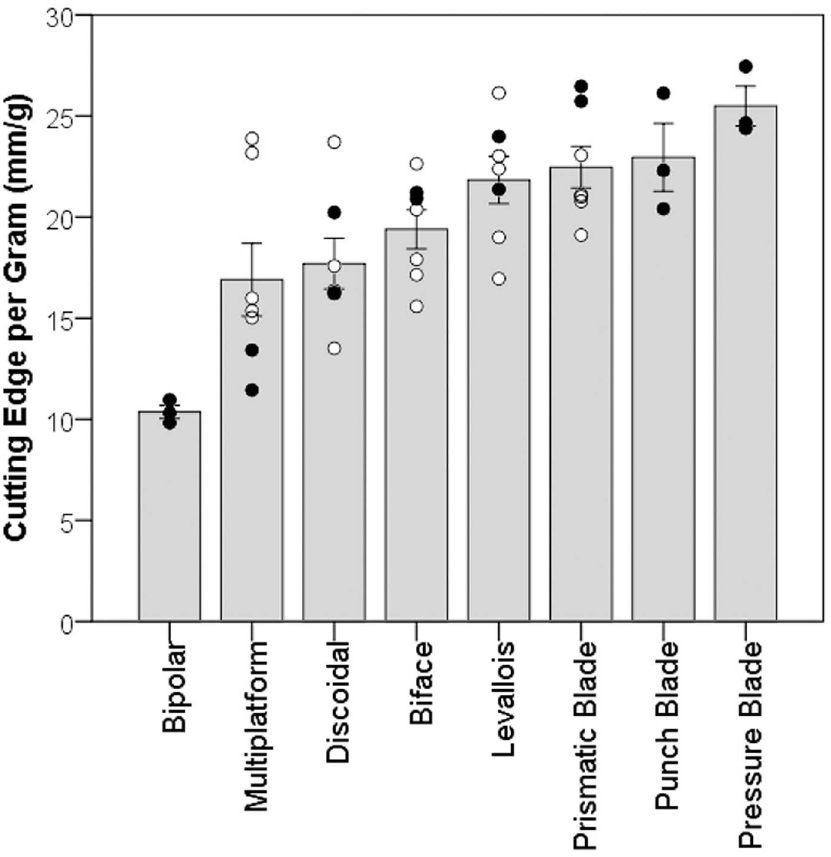
Fig 2. Bar chart, with one standard error bars and each data point superimposed, showing the cutting edge per gram values for each repetition of bipolar ( N = 3; μ = 10.36), multiplatform ( N = 7; μ = 16.90), discoidal ( N = 7; μ = 17.69), biface ( N = 7; μ = 19.39), Levallois ( N = 7; μ = 21.83), prismatic blade ( N = 7; μ = 22.46), punch blade ( N = 3; μ = 22.95) and pressureblade ( N = 3; μ = 25.49) knapping. Open circles representthe results from the intermediate knapperand closed circles represent the expert